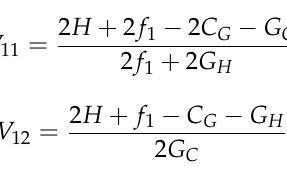
Figure 6. Influence of y on the evolutionary equilibrium stable strategy of z . Region 1 is using regular masks; region 2 is using EFMs.